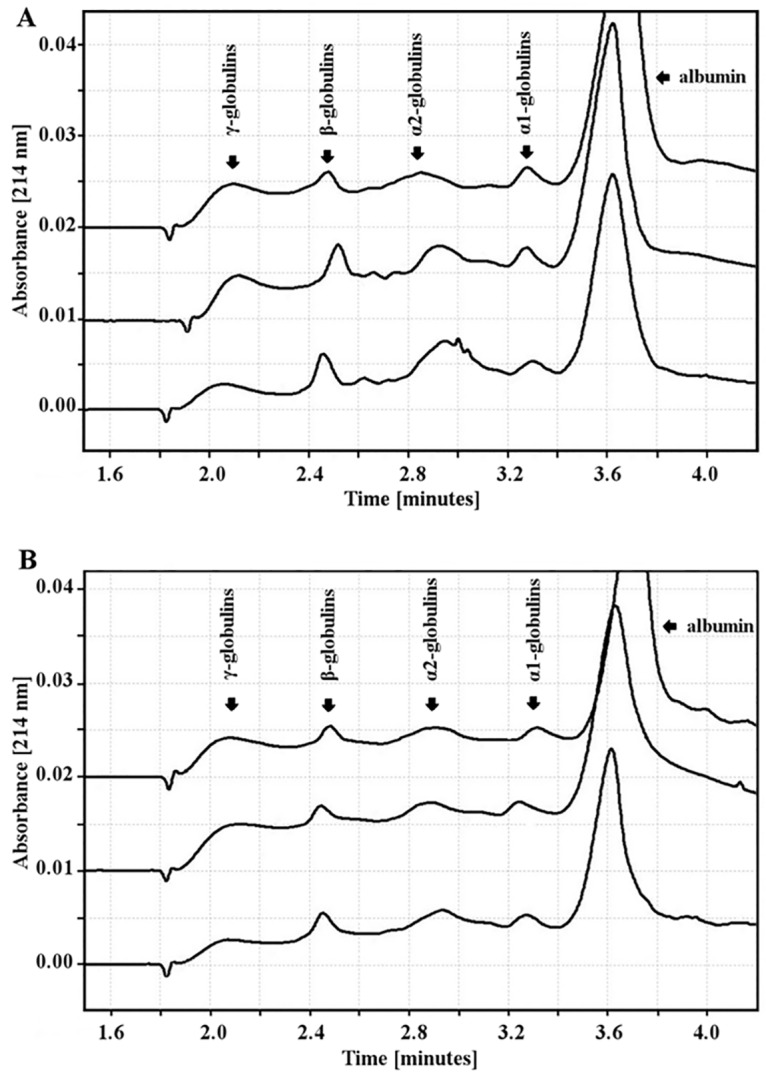
Exemplary profiles of the serum proteins of smoking (A) and non-smoking (B) women during pregnancy.